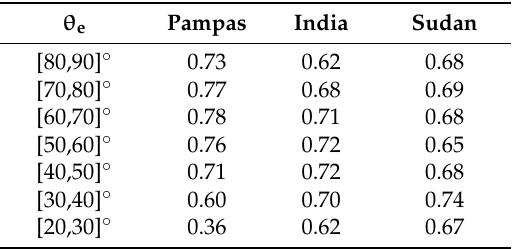
Table 2. Pearson correlation coefficients of CyGNSS reflectivity Γ LHCP,CyGNSS and SMAP-derived soil moisture content (SMC) for different elevation angles θ e , over specific target areas: Argentinian Pampas, India, and